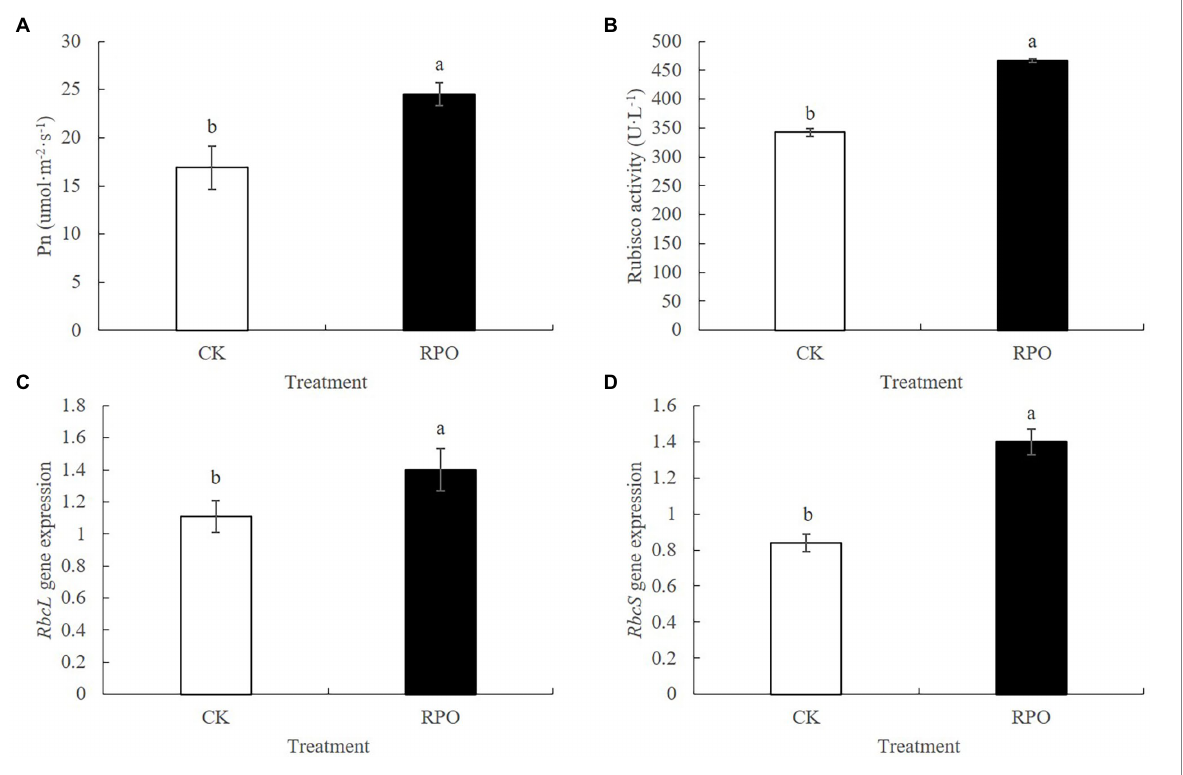
FIGURE 3 Effect of RPO film on Photosynthetic Correlation Index of sweet pepper leaves. (A) Photosynthetic rate; (B) Rubisco activity; (C) RbcL gene expression; (D) RbcS gene